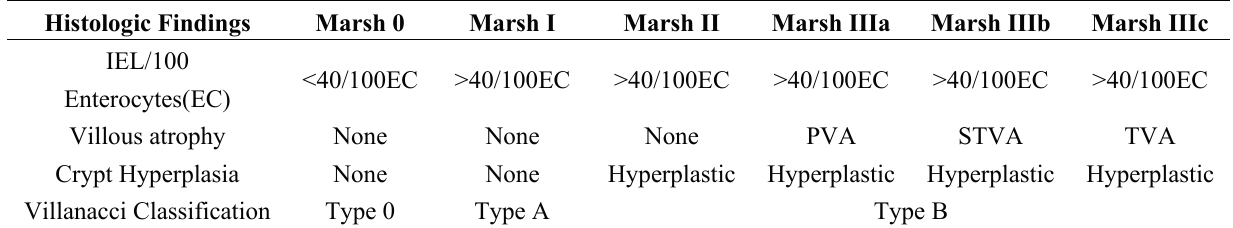
Table 2. Comparison of Marsh modified (Oberhuber) Histological classification and Villanacci classification of Celiac